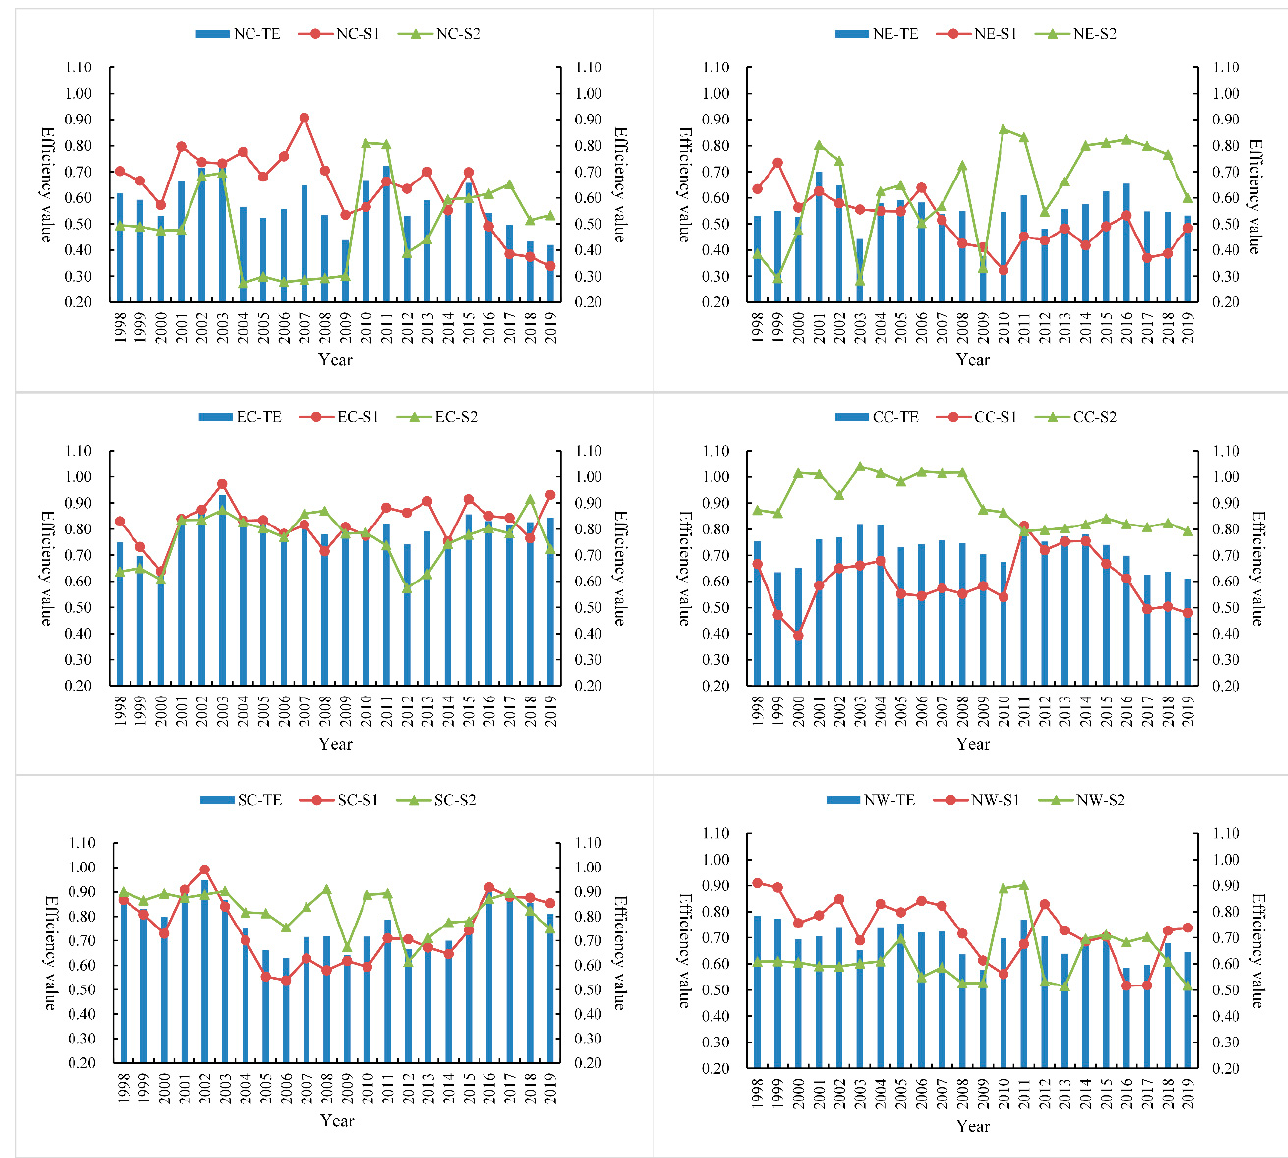
Figure 7. Comparative trend chart of sub-link efficiency for regional differences in environmental efficiency of China’s power industry.